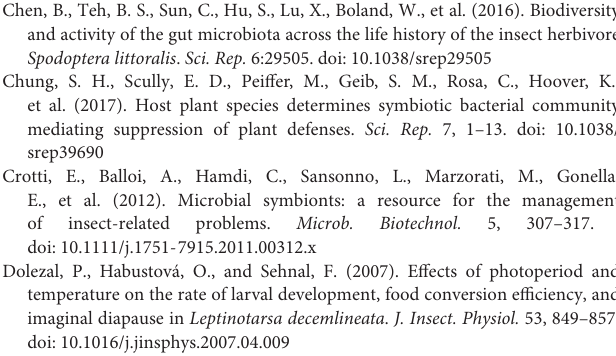
Supplementary Figure 1 | LEfse analysis showing biomarkers for Cluster A and Cluster B. The bar plot shows the relative abundance difference of these biomarkers between the two clusters. (Cluster A contains JM, WL, and WQ. Cluster B contains TC, TCQ, CX, XYI, XYII, and HL.) (A − J) Relative abundance of each biomarker in Cluster A and Cluster B. Supplementary Figure 2 | LEfse analysis showing the biomarkers between TC and TCQ. The bar plot shows the relative abundance difference for each biomarker between TC and TCQ. (A–H) Relative abundance of each biomarker in TC and TCQ. Supplementary Figure 3 | LEfse analysis for XYI and XYII. The bar plot shows the difference in relative abundance for each biomarker identified by Lefse between XYI and XYII. (A–D) Relative abundance of each biomarker in XYI and